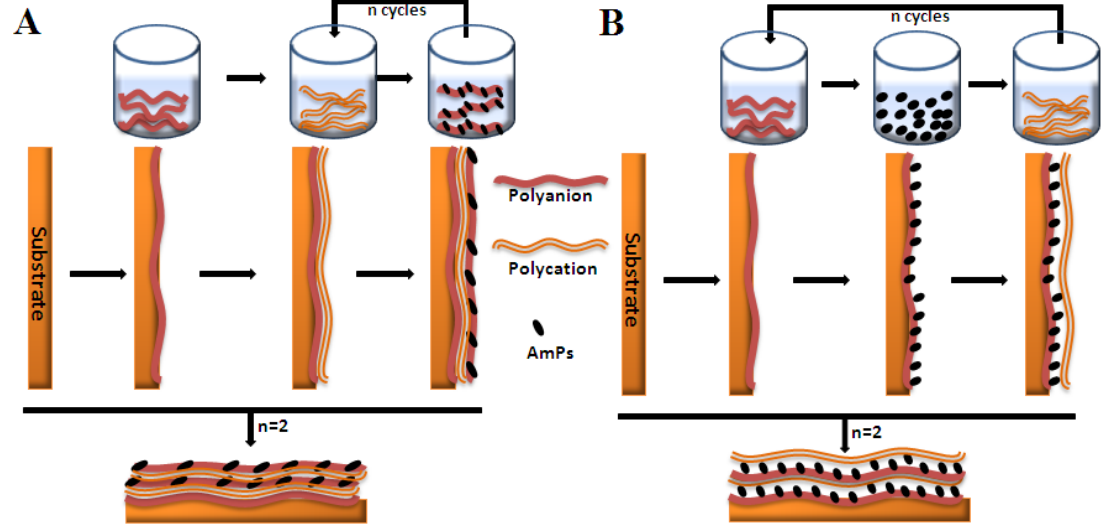
Figure 5. Typical schematic diagram of layer by layer (LbL) methods: (A) The immobilization of peptides is through mixing peptides and the polyanions. (B) The immobilization of peptides is through adsorption onto the pre-existing polyanion